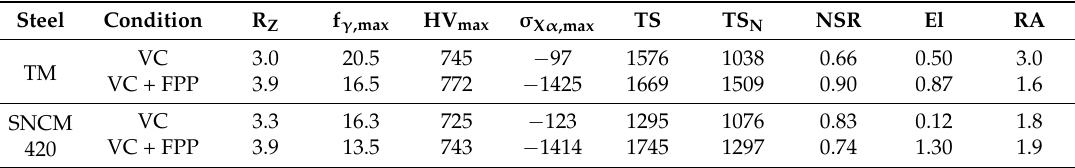
Table 3. Properties on the surface and in the surface-hardened layer and tensile properties of TM and SNCM420 steels subjected to various process.